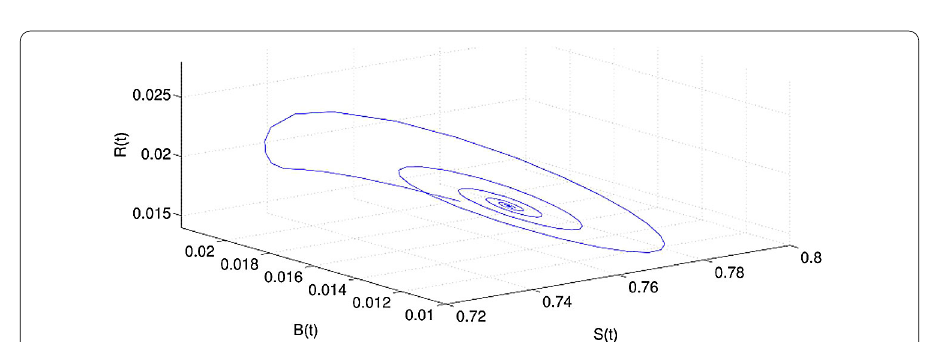
Figure 5 Dynamic behavior of system (41): projection on S-B-R with τ = 4.0628